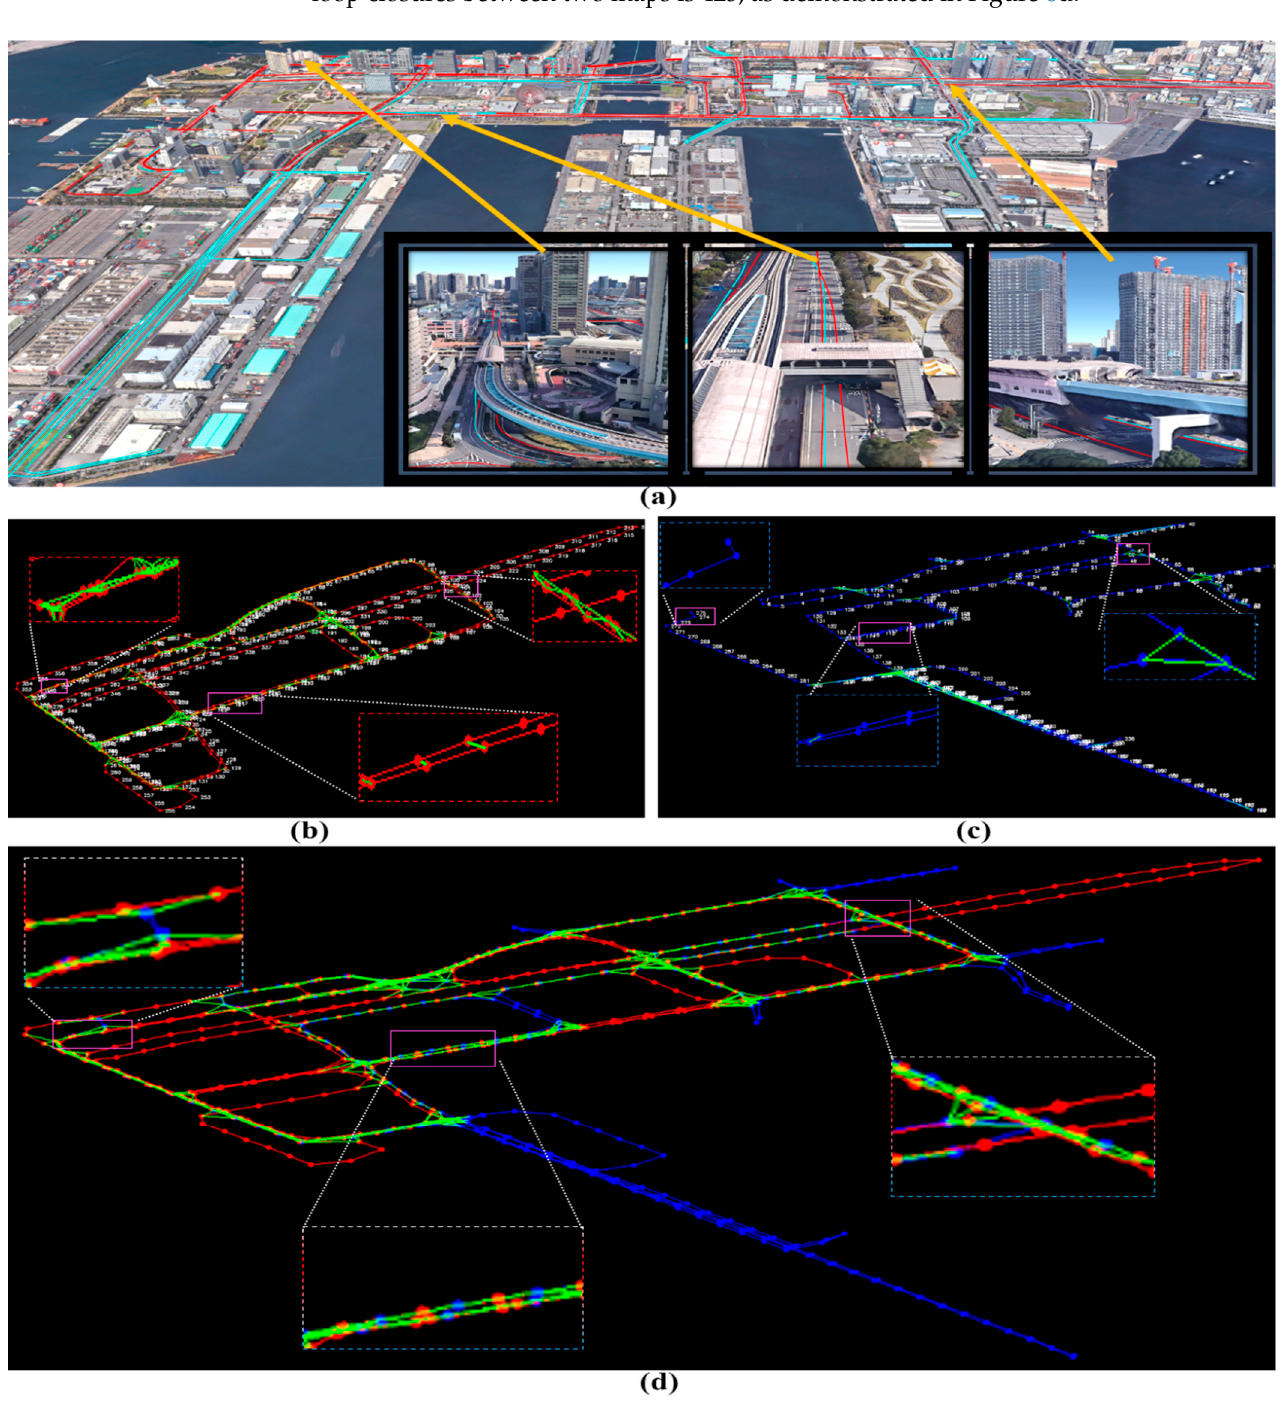
Figure 6. Mapping Tokyo’s waterfront with high buildings, dense trees and railways using two collection phases. ( a ) The vehicle trajectories in the two phases highlight critical road segments. ( b , c ) The node distribution in each phase with the local loop closures by green links. ( d ) Map combination links between two